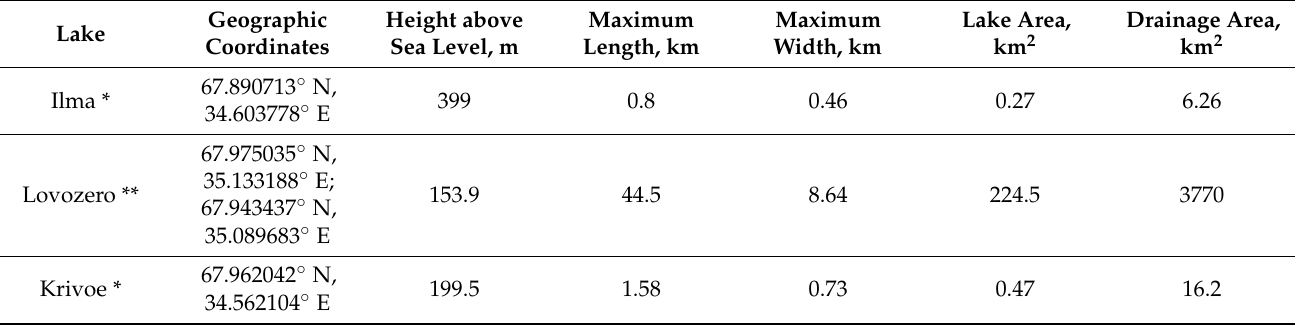
Table 1. Geographic coordinates of sampling points, morphometric parameters of the studied